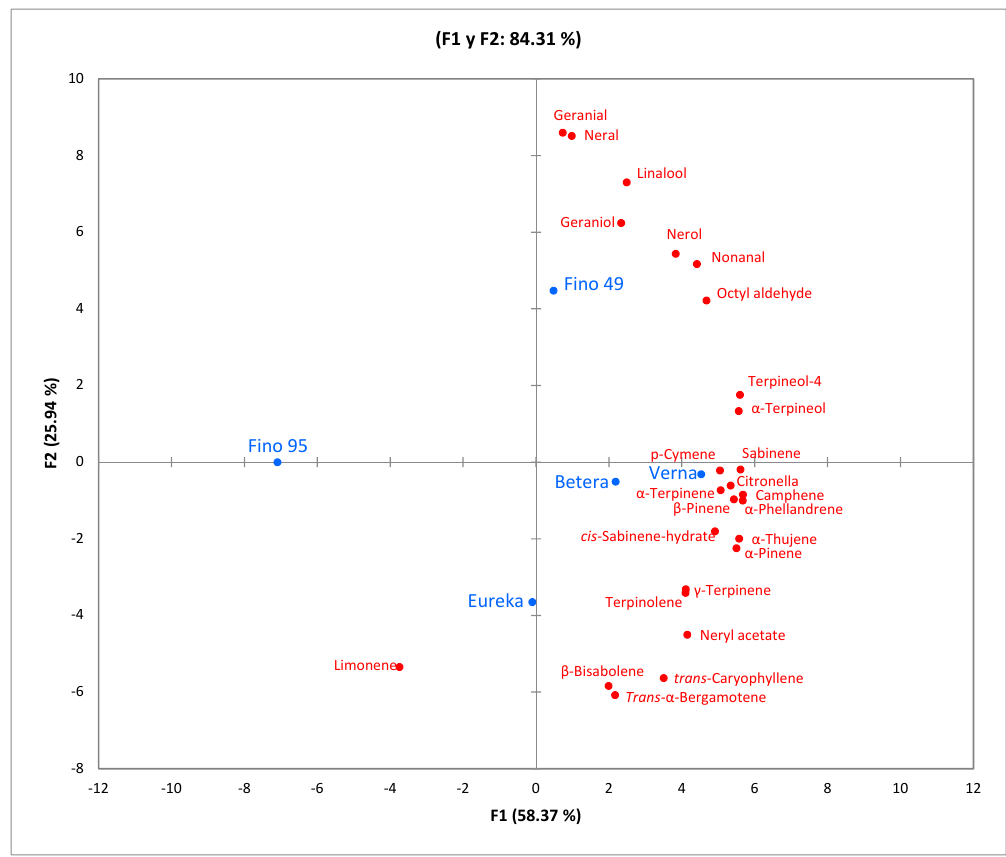
Figure 2. Principal component analysis (PCA) plot showing the relationship among volatile compounds and the factor “variety” ( n = 9).